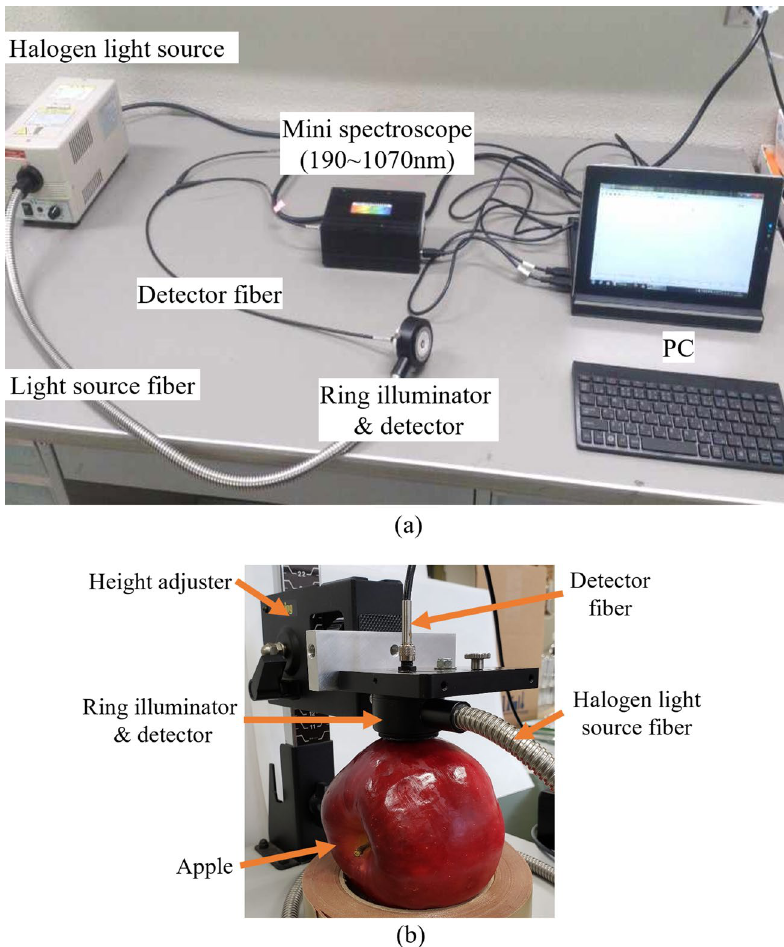
Figure 10. Instruments and experimental setup of the spatially resolved interactance spectroscopy system. Instrument components ( a ) and interactance measurement of a sample ( b ) with the system.